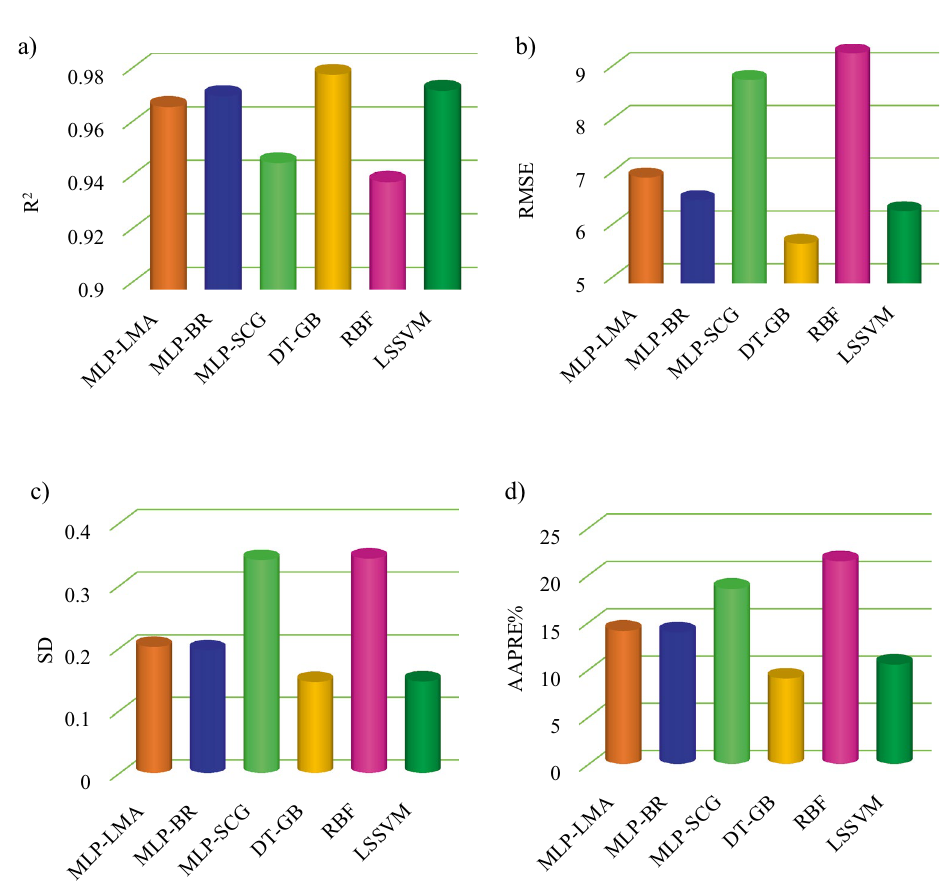
Figure 12. Comparison of statistical errors of the intelligent